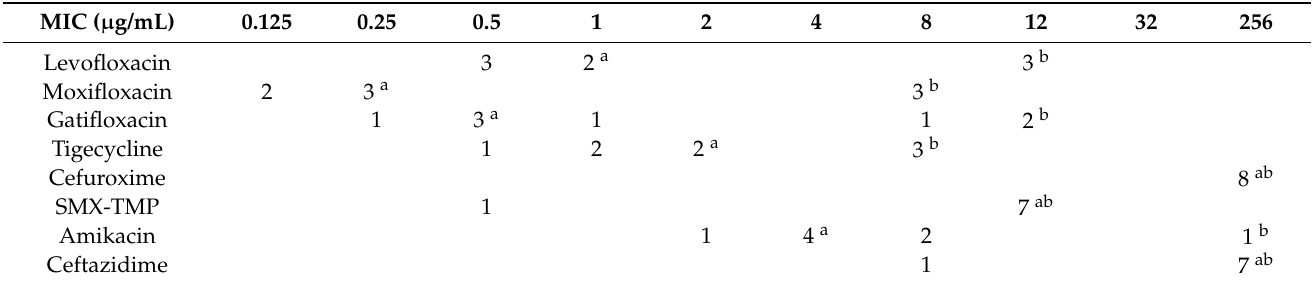
Table 3. Minimum Inhibitory Concentration for Stenotrophomonas maltophilia